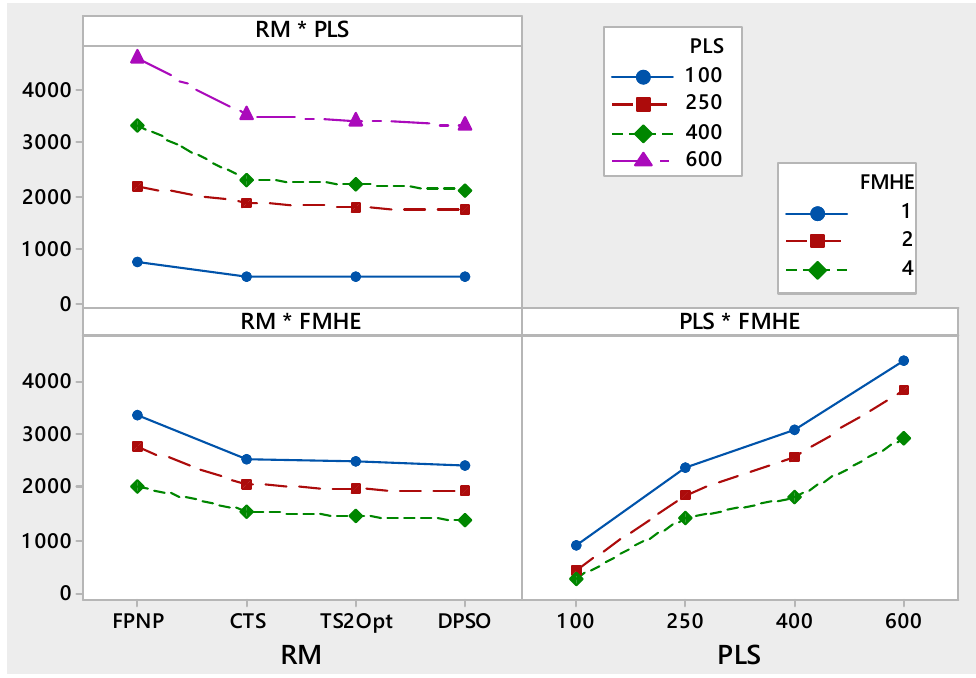
Figure 4. Two-way interaction effects for the PRP.